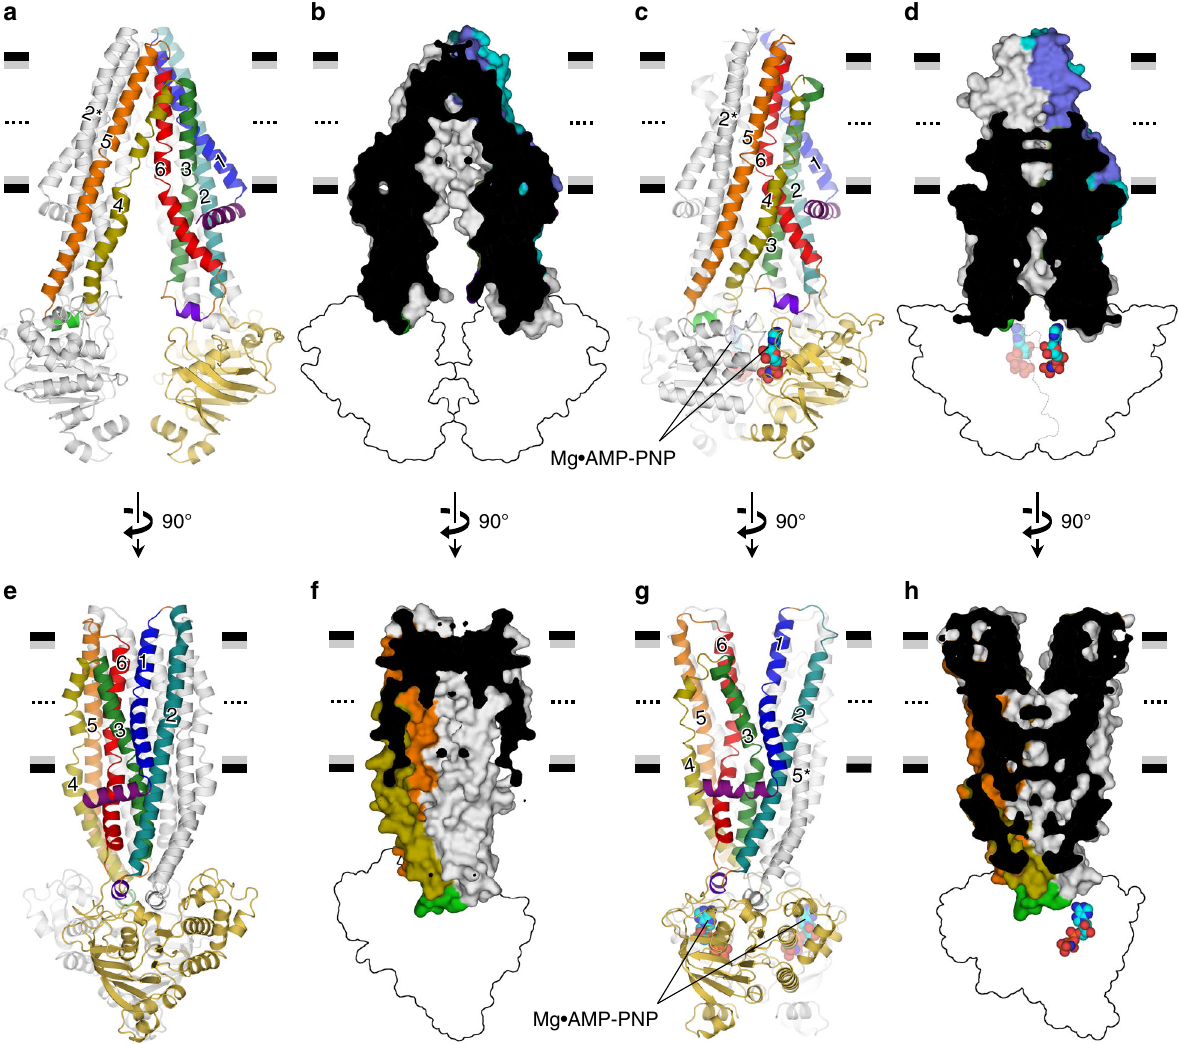
Fig. 1 Apo inward-facing and Mg 2 + (cid:129) AMP-PNP-bound outward-facing structures of QTA CmABCB1. Anterior ( a – d ) and lateral ( e , f ) views of the QTA CmABCB1 structures in the inward- ( a , b , e , f ) and outward-facing ( c , d , g , h ) conformations are shown as cartoon representations ( a , c , e , g ) or as a cutaway surface representations of the TMDs with the interior shown in black ( b , d , f , h ). One subunit is colored, and the other is shown in gray. Secondary structure elements and amino acid residues belonging to the other subunit are indicated by asterisks in all fi gures. Horizontal black and gray bars represent the expected positions of the hydrophilic and hydrophobic surfaces of the lipid membrane, respectively. In b , f , d , h , the cross-section passes through a crystallographic twofold axis. NBDs are shown as outlines for simplicity. In c , d , g , h , bound Mg 2 + (cid:129) AMP-PNP molecules at NBDs are shown as